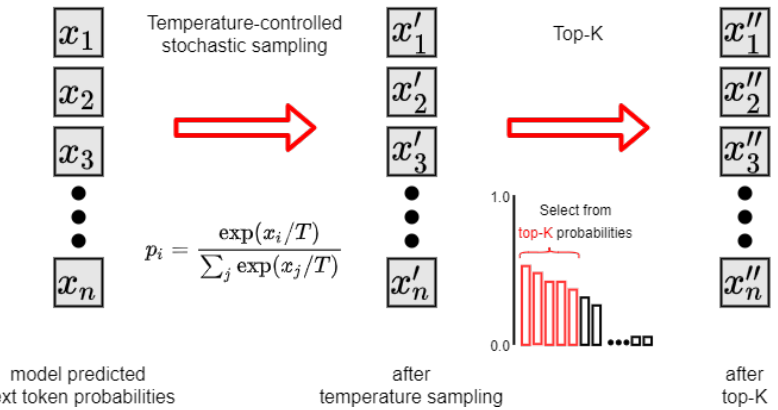
Figure 13. Temperature-controlled stochastic sampling method with top- k